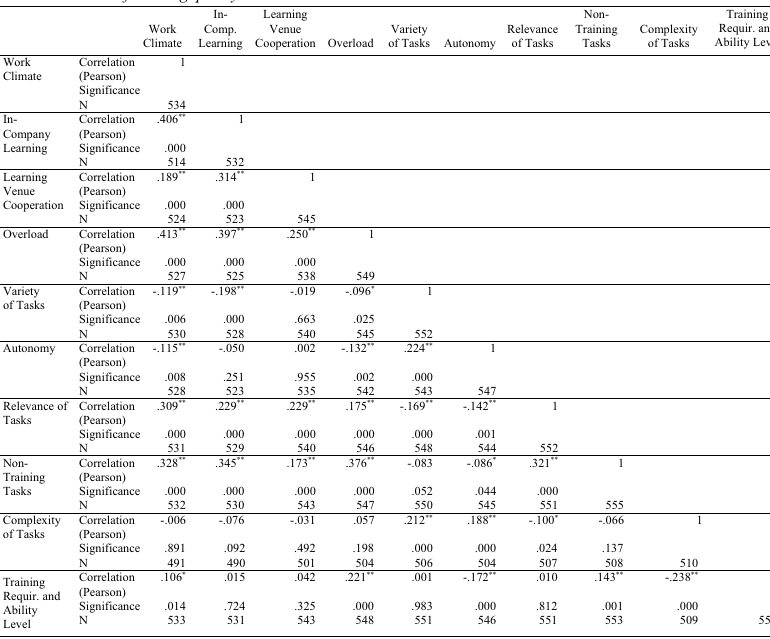
Table 11 Intercorrelations of training quality scales Intercorrelations of training quality